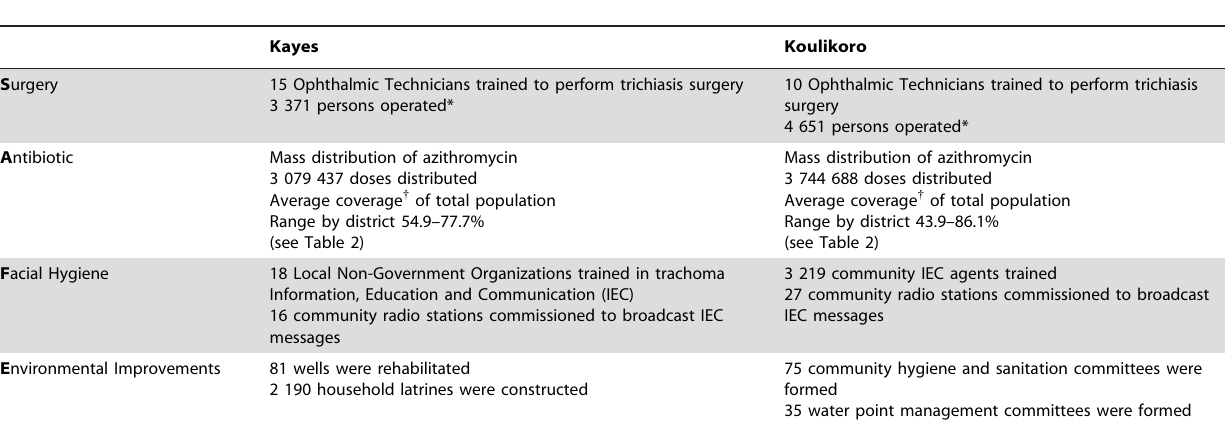
Table 1. SAFE Interventions in Kayes and Koulikoro Regions of Mali 2002–2006 +